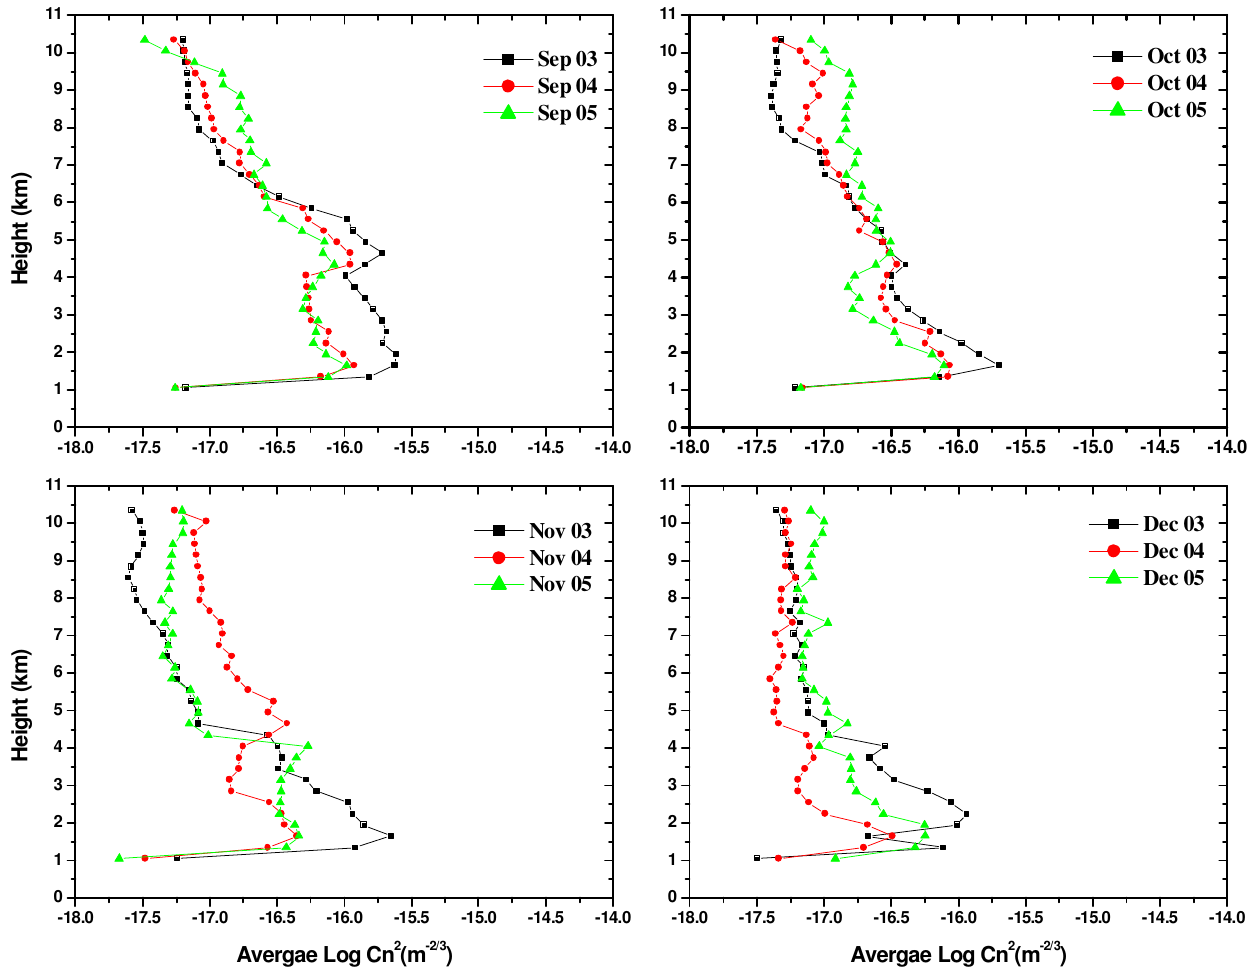
Fig. 11. Height profile of mean Log C 2 n showing inter-annual features for the months of September, October, November and